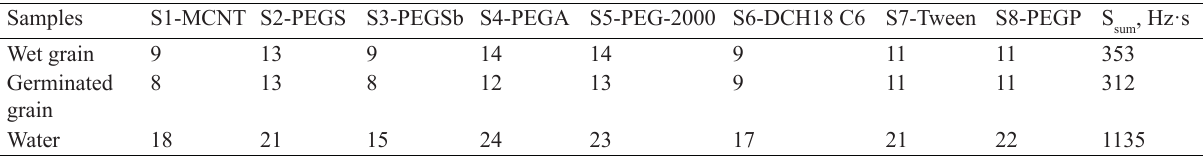
Table 3 “Visual imprint” area of the sensor signals (S1-S8) in the equilibrium gas medium above the samples